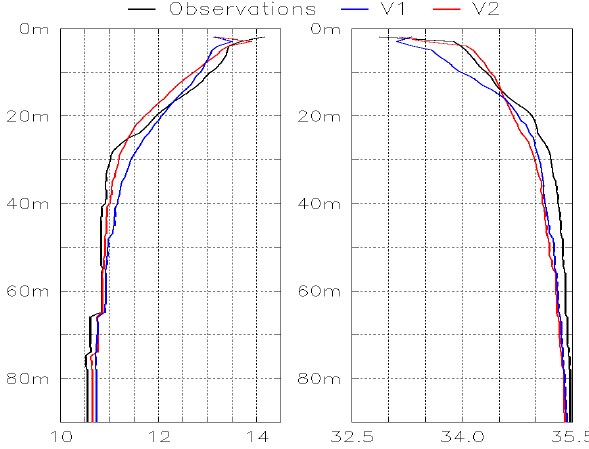
Figure 14 : Mean temperature (on the left) and salinity (on the right) profiles from 0 to 100m of depth for observations (black line), V1 (blue line) and V2 (red line)and for the period from May the 1 st to May the 24 th 2009.The area corresponds to the shelf covered by PELGAS data showed in Fig. 12 and 13.